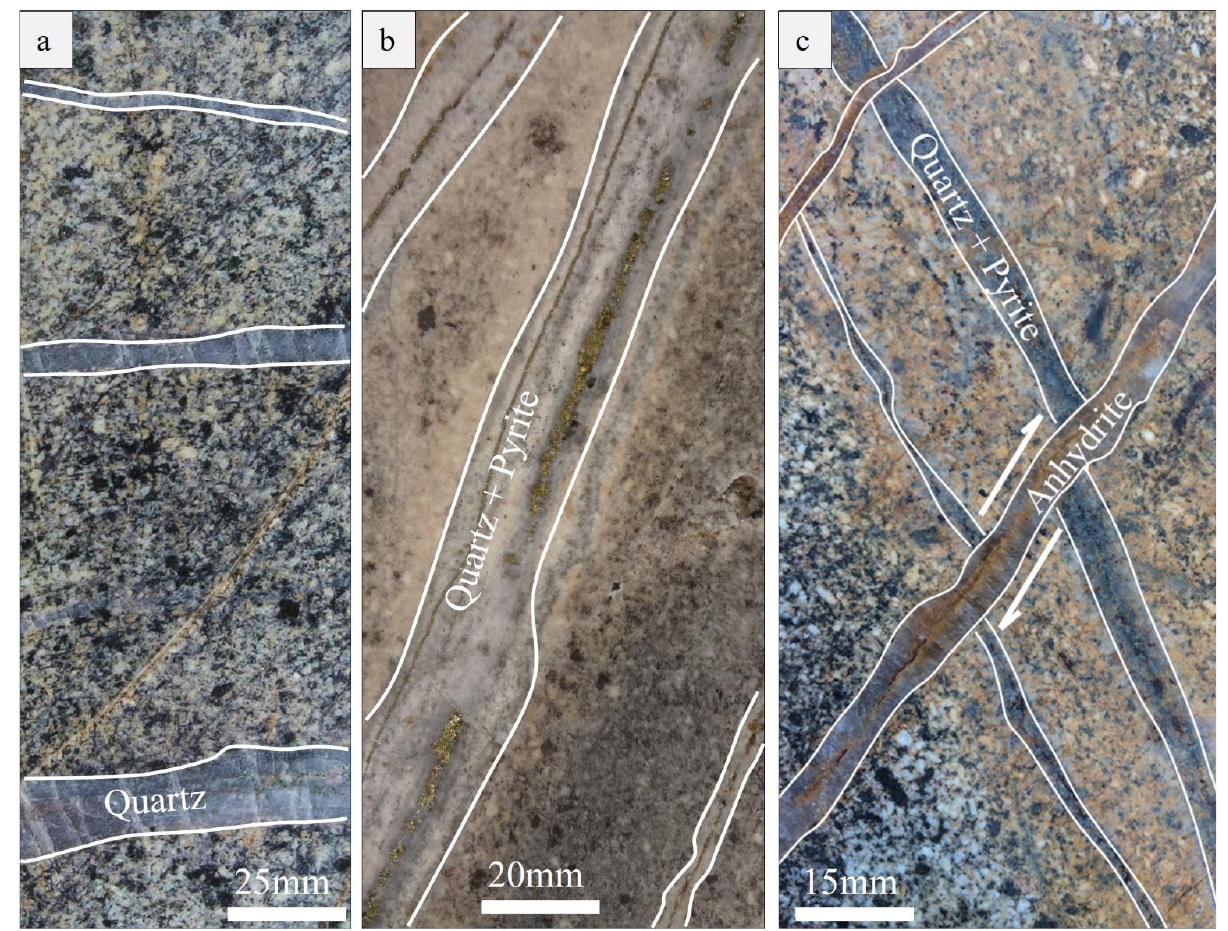
Figure 7. Photographs of veins from drill core with porphyry hosts; ( a ) flat dipping barren quartz sheeted vein; ( b ) steep dipping quartz-pyrite sheeted vein with discontinuous bleached halo; ( c ) steep dipping quartz-pyrite sheeted vein with halo (earthy brown) crosscut by steep dipping anhydrite sheeted vein.